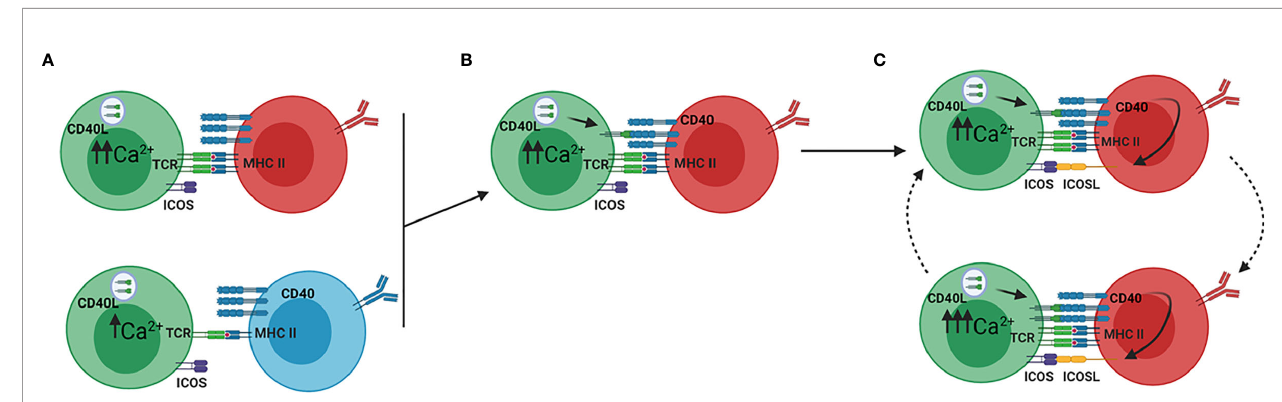
FIGURE 3 | ICOSL driven feed forward model of serial entanglement. (A) Antigen speci fi c B cells present antigen to Tfh cells via MHCII on the B cell surface. Tfh cells (green) bind the MHCII-antigen complex via the T cell receptor (TCR), which activates calcium signaling within the Tfh cell. B cells expressing high af fi nity BCRs (red) present more antigen than those expressing low af fi nity BCRs (blue), thereby inducing a more Ca 2+ release. (B) Ca 2+ signaling in the Tfh cells induces translocation of CD40L to the Tfh cell surface, which binds CD40 on the B cell surface. (C) Stimulation of CD40 on B cells induces the expression of ICOSL on the B cell. ICOSL binding to ICOS on the Tfh cell surface induces increased Ca2 + signaling, which again leads to translocation of CD40L to the Tfh cell surface. In this model, B cells increase their expression of ICOSL, which prepares them for stronger entanglement with Tfh cells. Adapted from reference